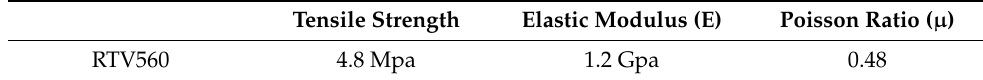
Figure 2. Silicone adhesive film. Table 1. Physical parameters of organic silica adhesive.